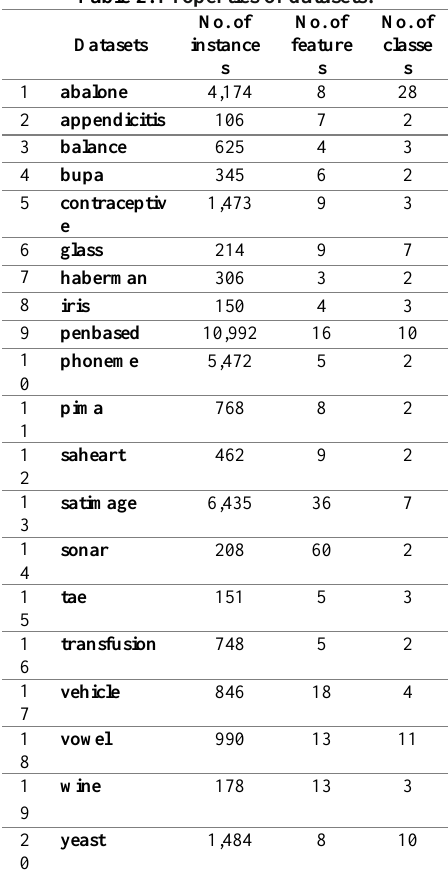
Table 2. Properties of datasets.